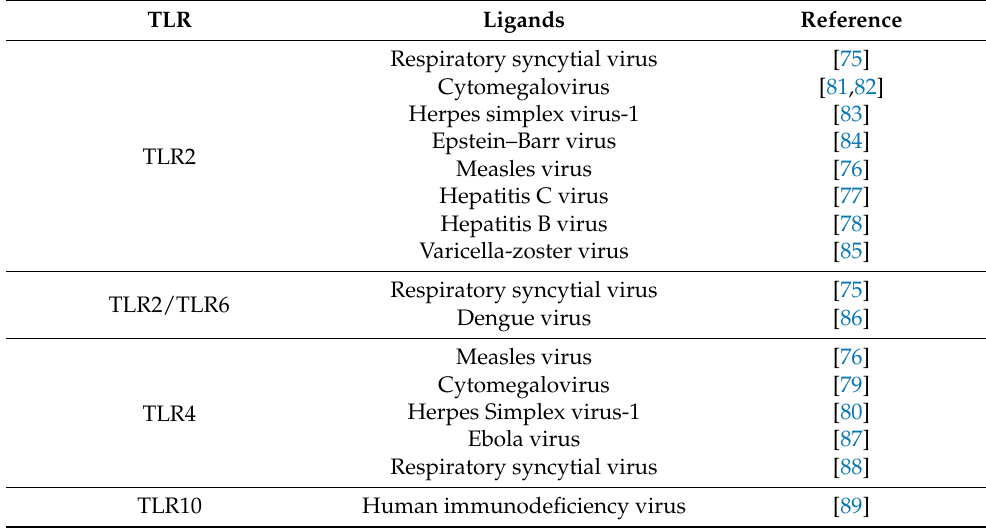
Table 2. Viruses interact with